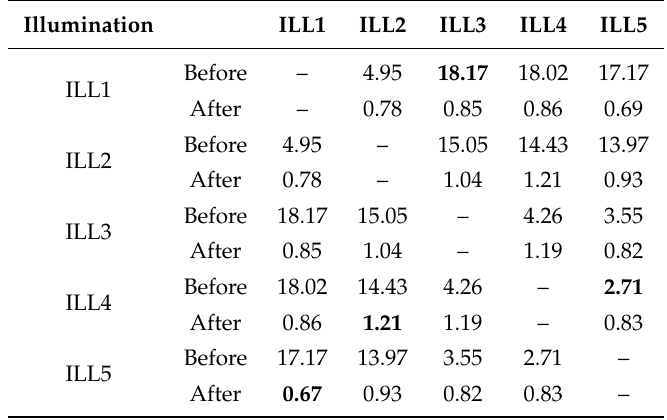
Table 4. Average color difference between region of interest under different illuminances before and after